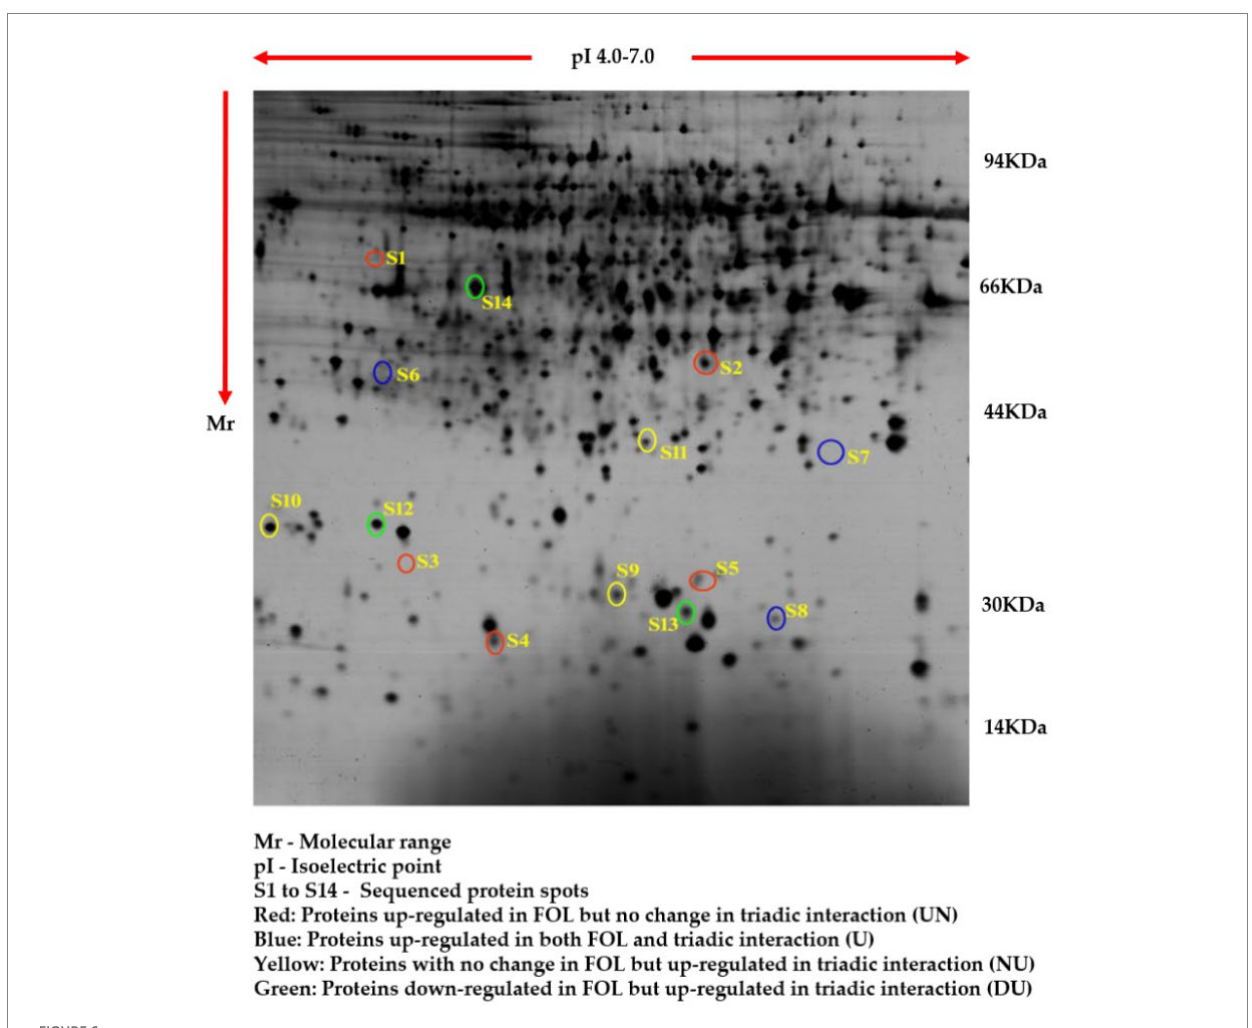
FIGURE 6 Proteome analysis of healthy tomato roots by